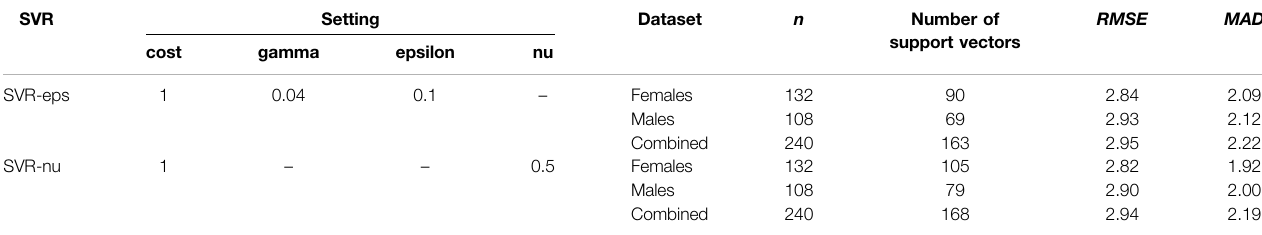
TABLE 2 | Model settings and system ef fi ciencies for three different datasets of the CHS cohort ( n (cid:1) 240, blood samples) in two SVR models. SVR Setting